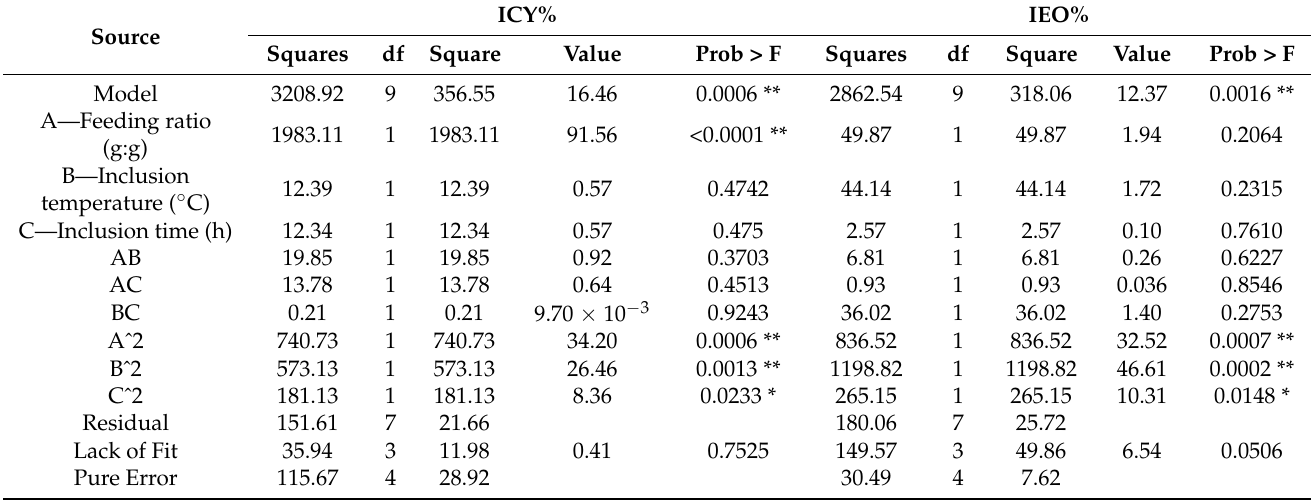
Table 4. Analysis of variance of the ICY% and IEO% index model.